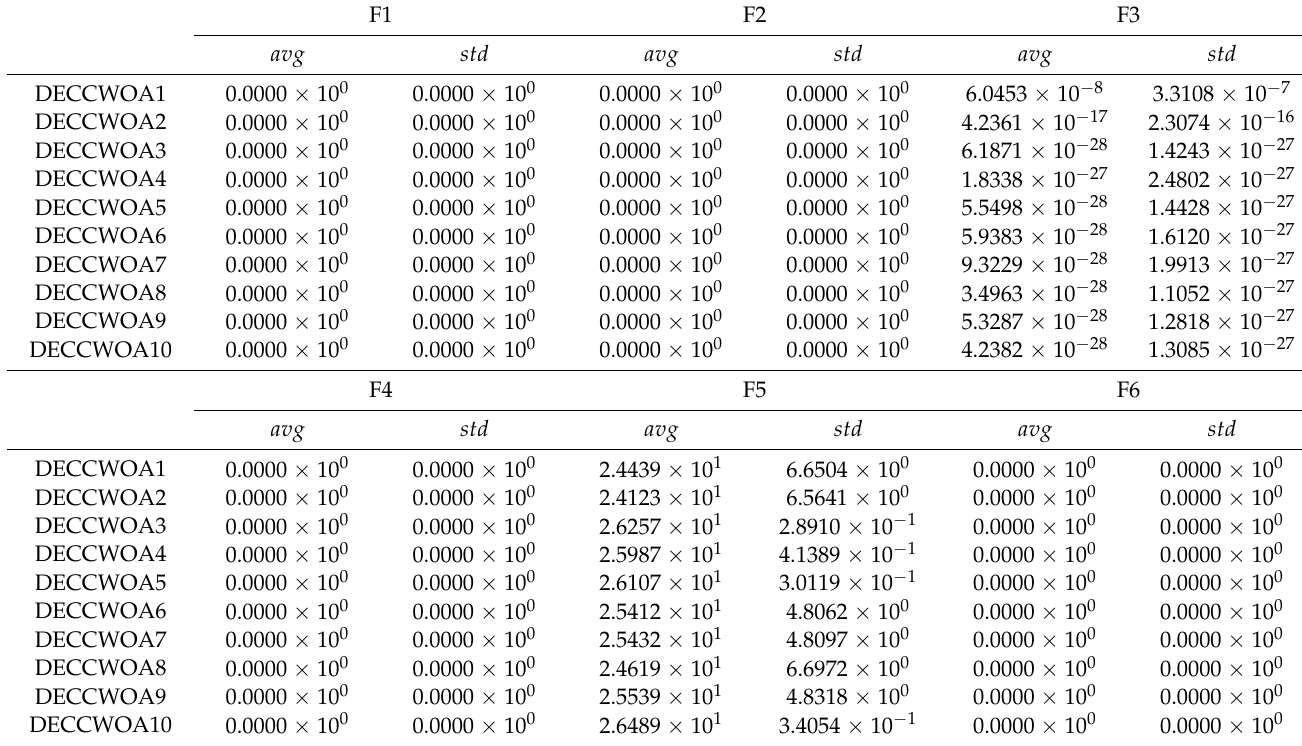
Table A2. Experimental results for analysis of key parameter p 2